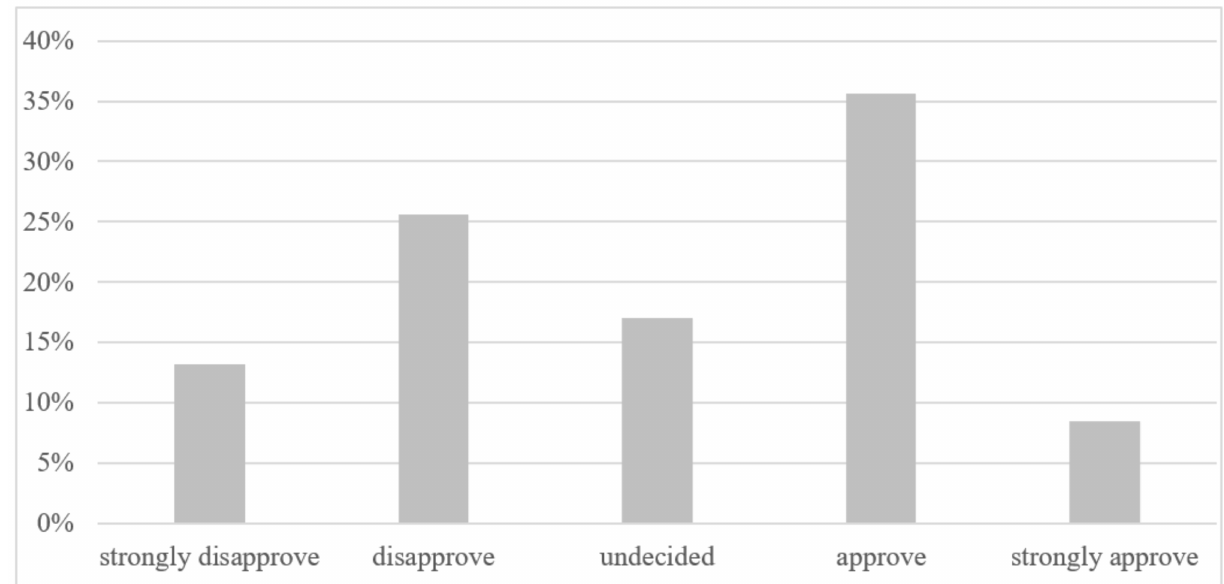
Figure 6. Financing investments in the traditional energy sector still represents a significant share in the banks’ loan portfolio (in percent). Source: own